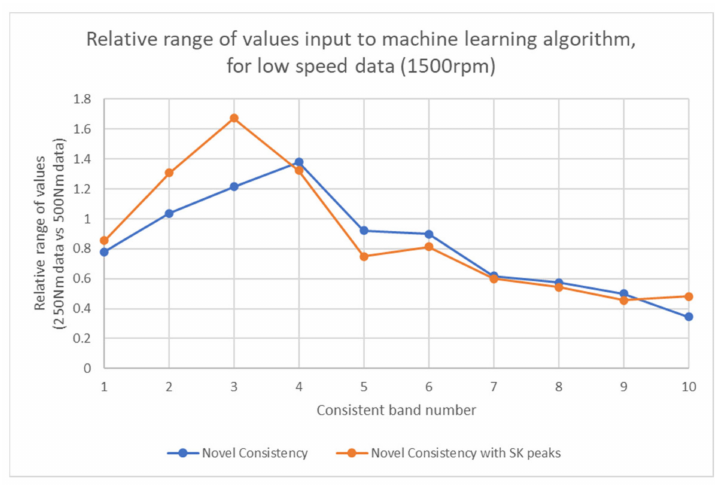
Figure 16. Relative range of input